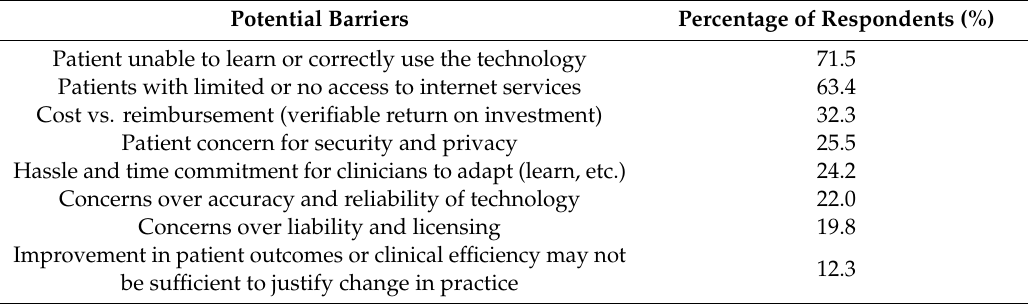
Table 9. Barriers that might limit e ff ectiveness of mRehab e ff ectiveness in supporting between-visit therapy interventions, all professions (select top three).